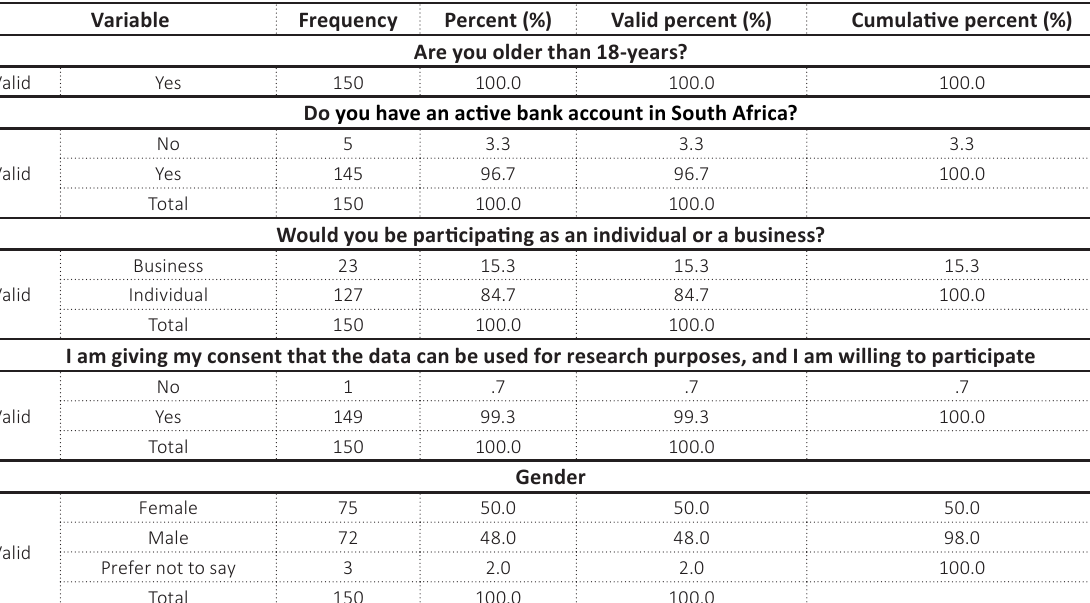
Table 1. Biographic